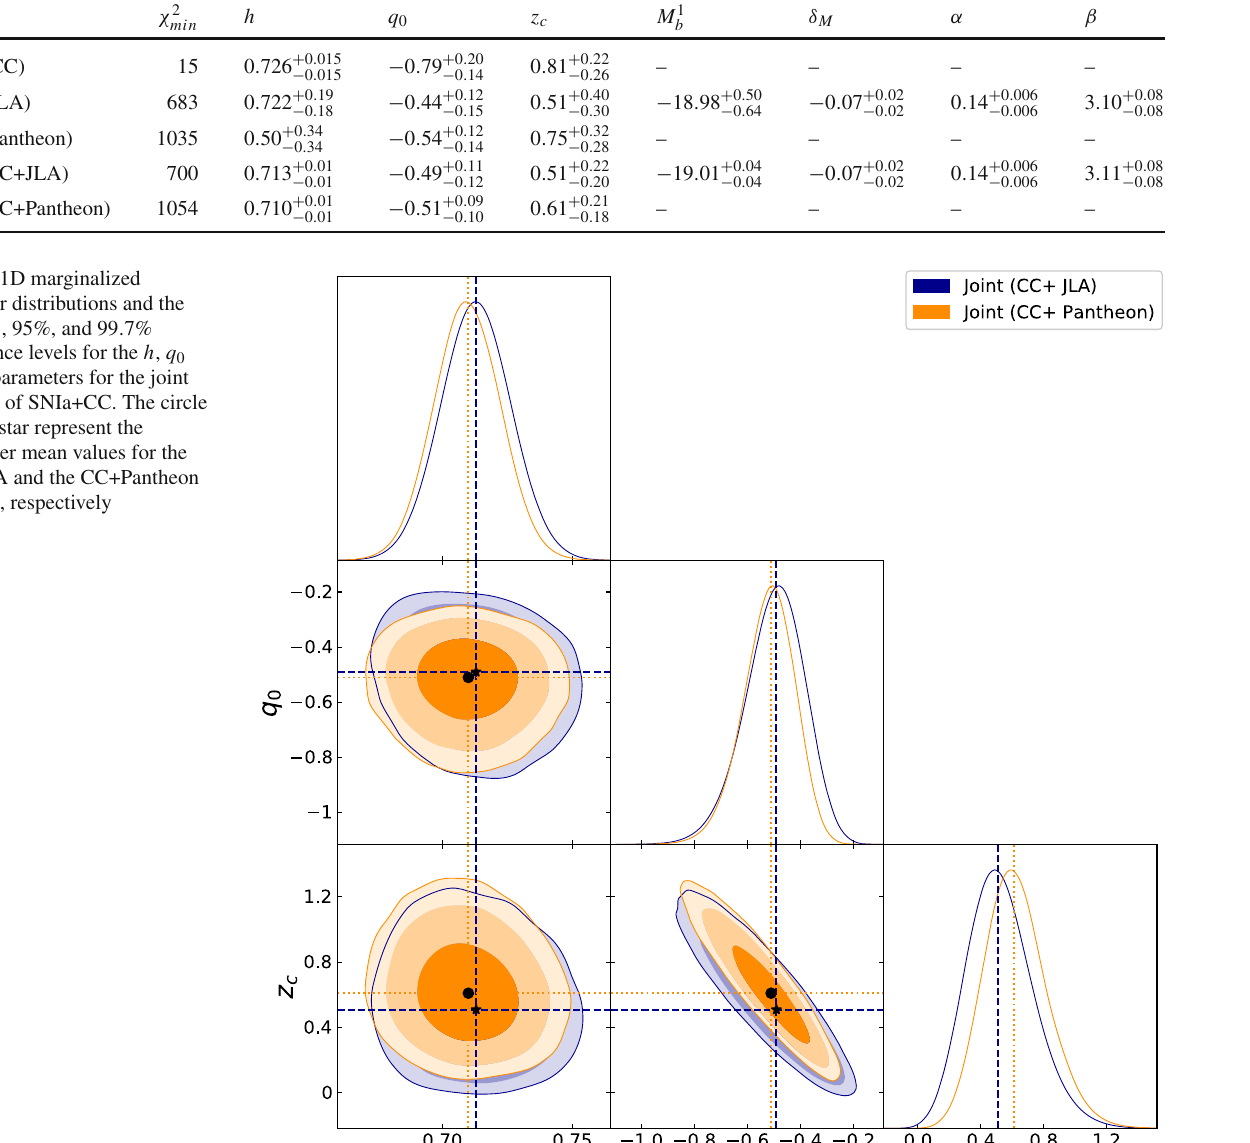
Table 1 Mean values for the model parameters ( h , q 0 , z c ) derived from OHD and SN Ia measurements Data set